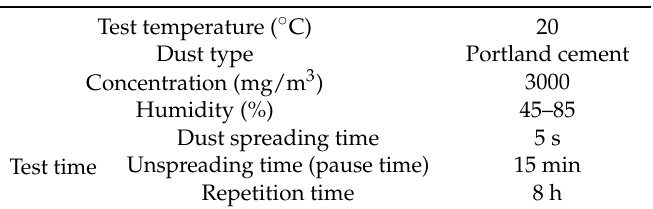
Table 8. Dust test conditions.